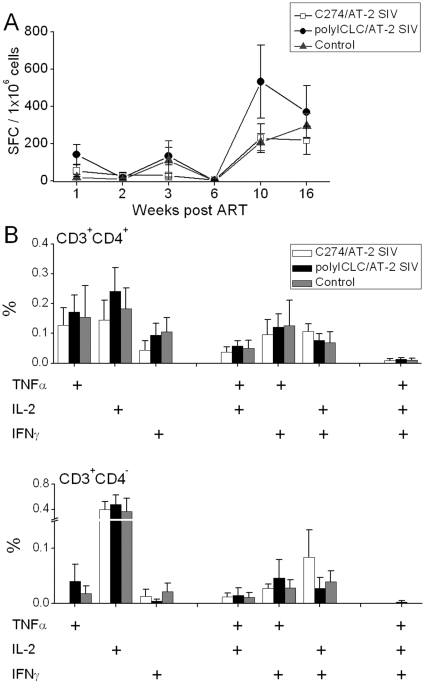
Similar SIV-specific responses in immunized and control animals.(A) Average SIV-specific (to AT-2 SIV) IFNγ ELISPOT responses are illustrated (±SEM). SIV specific responses were determined by subtracting the appropriate MV-induced background. (B) Percentage of cytokine producing (IFNγ, TNFα, IL-2 and combinations) CD3+CD4+ (upper panel) and CD3+CD4− (lower panel) cells were measured in PBMC, by flow cytometry at weeks 17–18 post-ART. Results shown in panels A and B (±SEM) are for 5 animals in the C274/AT-2 SIV group, 5 in the polyICLC/AT-2 SIV group and 4 in the control group.